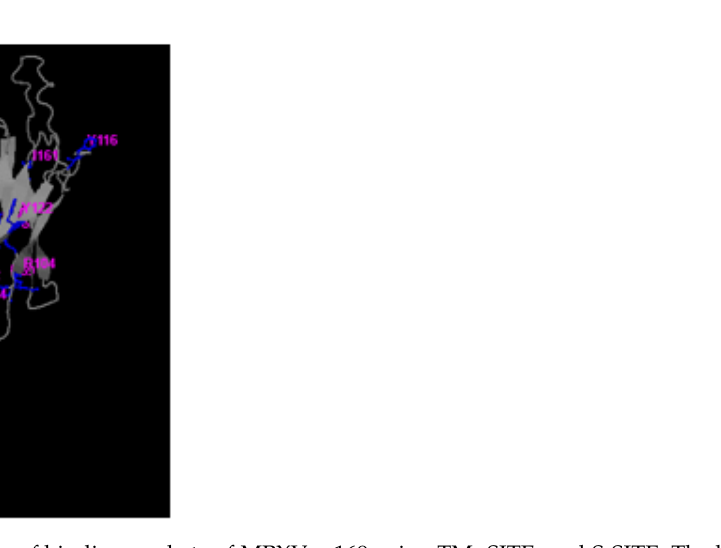
Figure 2. Identification of binding pockets of MPXVgp169 using TM ‐ SITE, and S ‐ SITE. The blue color region indicates the pocket residues, and the purple color indicates the name of the residues.